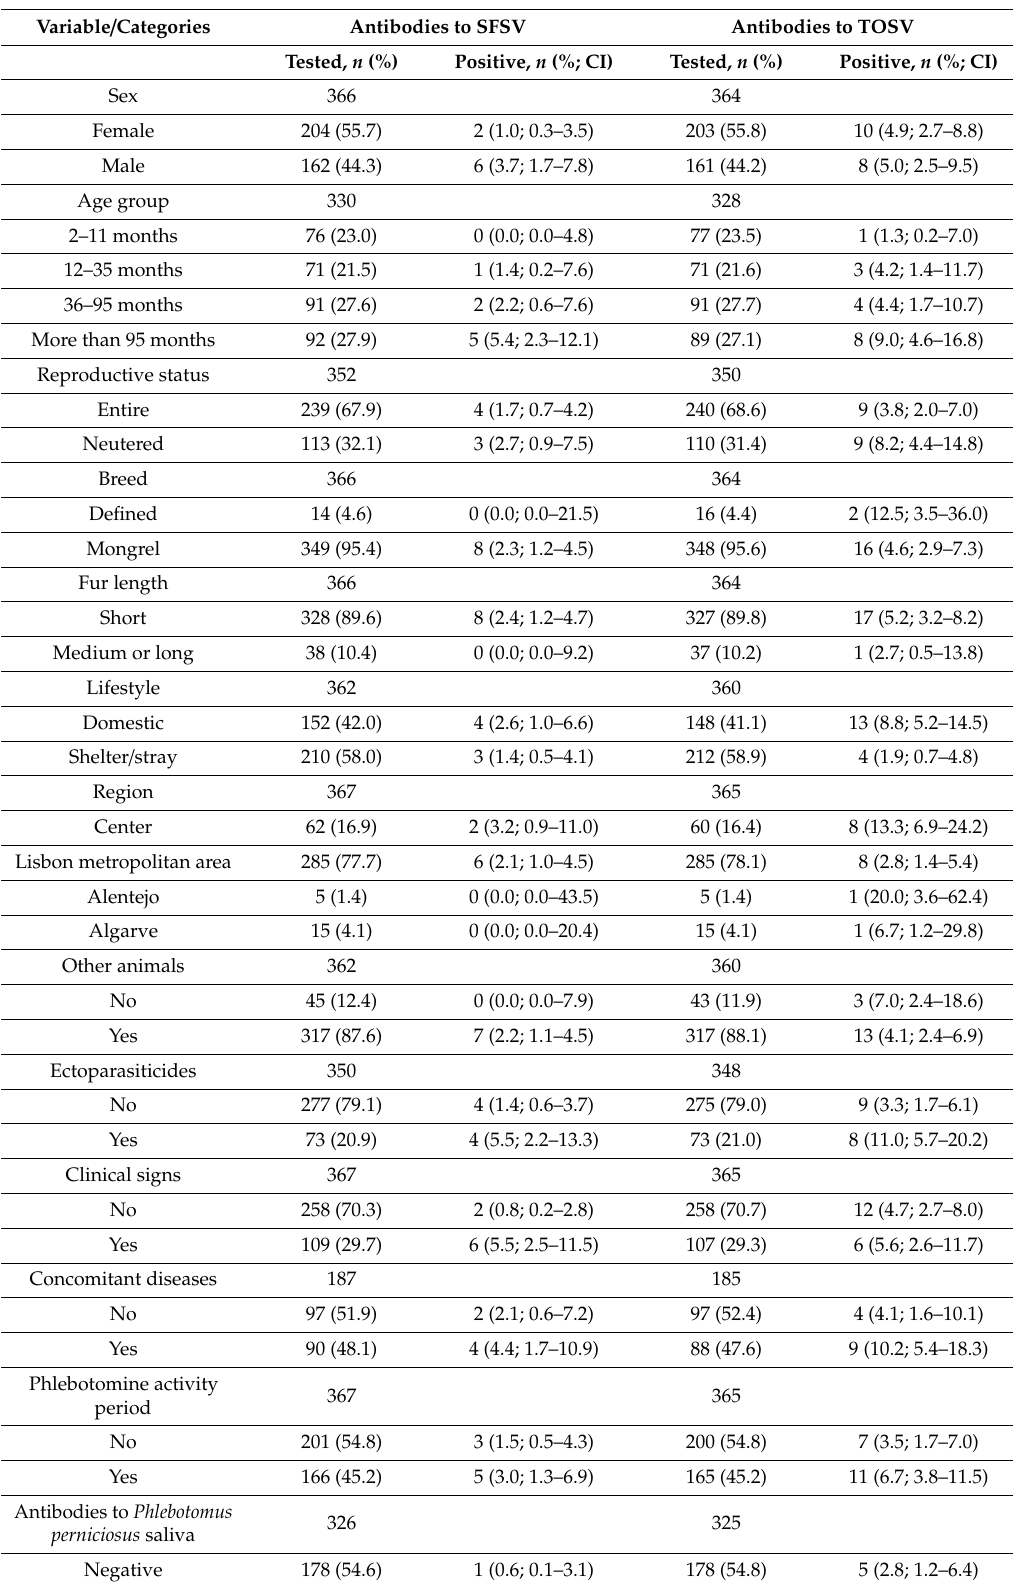
Table 1. Seroprevalence of antibodies against Sandfly Fever Sicilian virus (SFSV) and Toscana virus (TOSV) in cats from